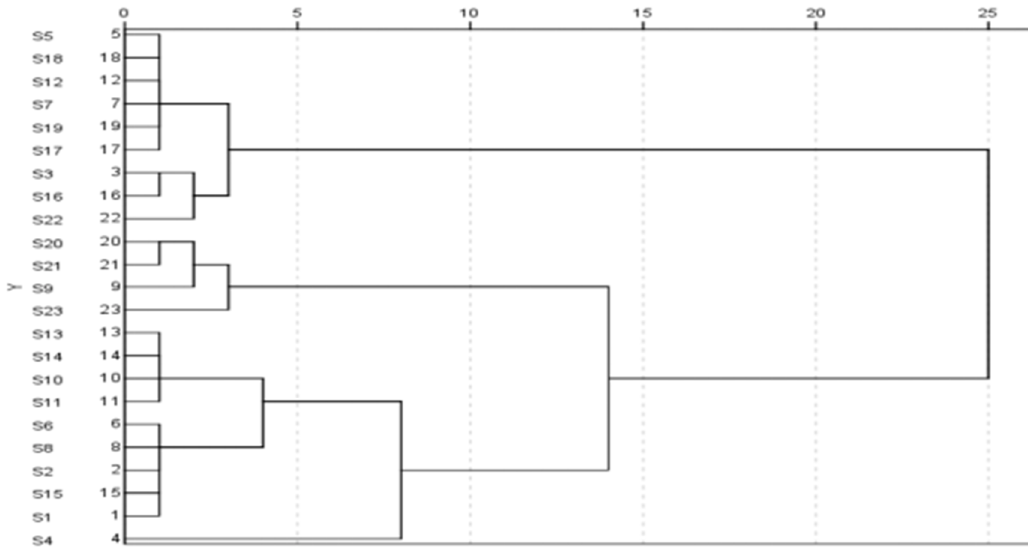
Figure 3. Cluster analysis dendrogram of sample.